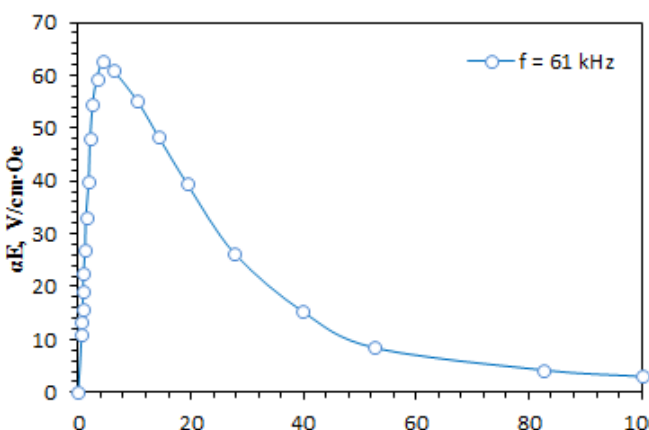
Fig. 3. Frequency dependence of the α E .